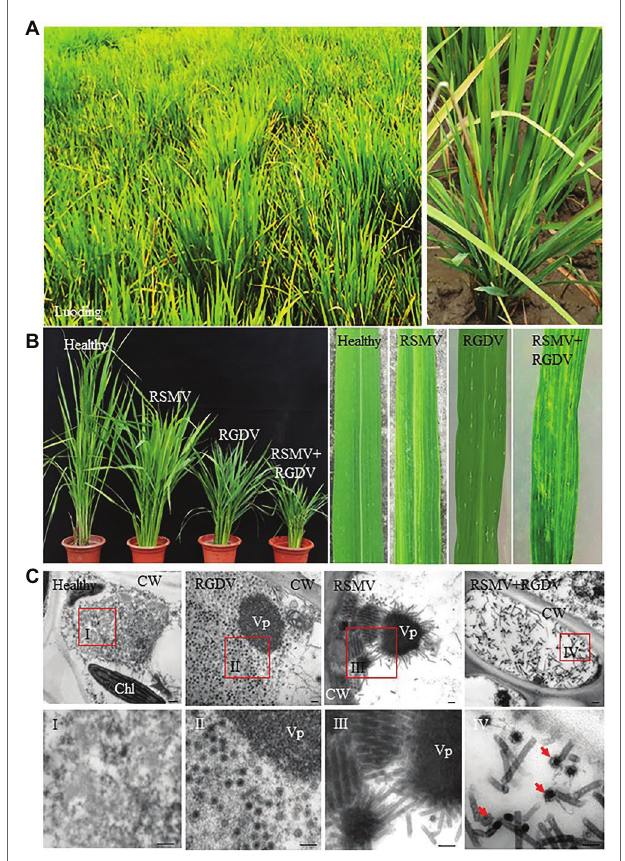
FIGURE 1 | Typical signs of Rice stripe mosaic virus (RSMV) and rice gall dwarf virus (RGDV) co-infection in rice. (A) Symptoms of virus-infected rice in the field (Luoding, Guangdong, China). (B) The dwarf and mosaic signs displayed on rice plants singly infected with RSMV, RGDV or co-infected with RSMV and RGDV. (C) Electron micrographs of virions in RSMV-infected, RGDV-infected, or co-infected rice leaves. Healthy rice leaf was as control. Panels I–IV are the enlarged images of the red boxed areas I–IV in the above panels. Red arrows indicate a RGDV virion adhered to a RSMV virion in the cytoplasm of co-infected rice leaf. CW, cell wall; Chl, chloroplast; and Vp, viroplasm. Bars, 100